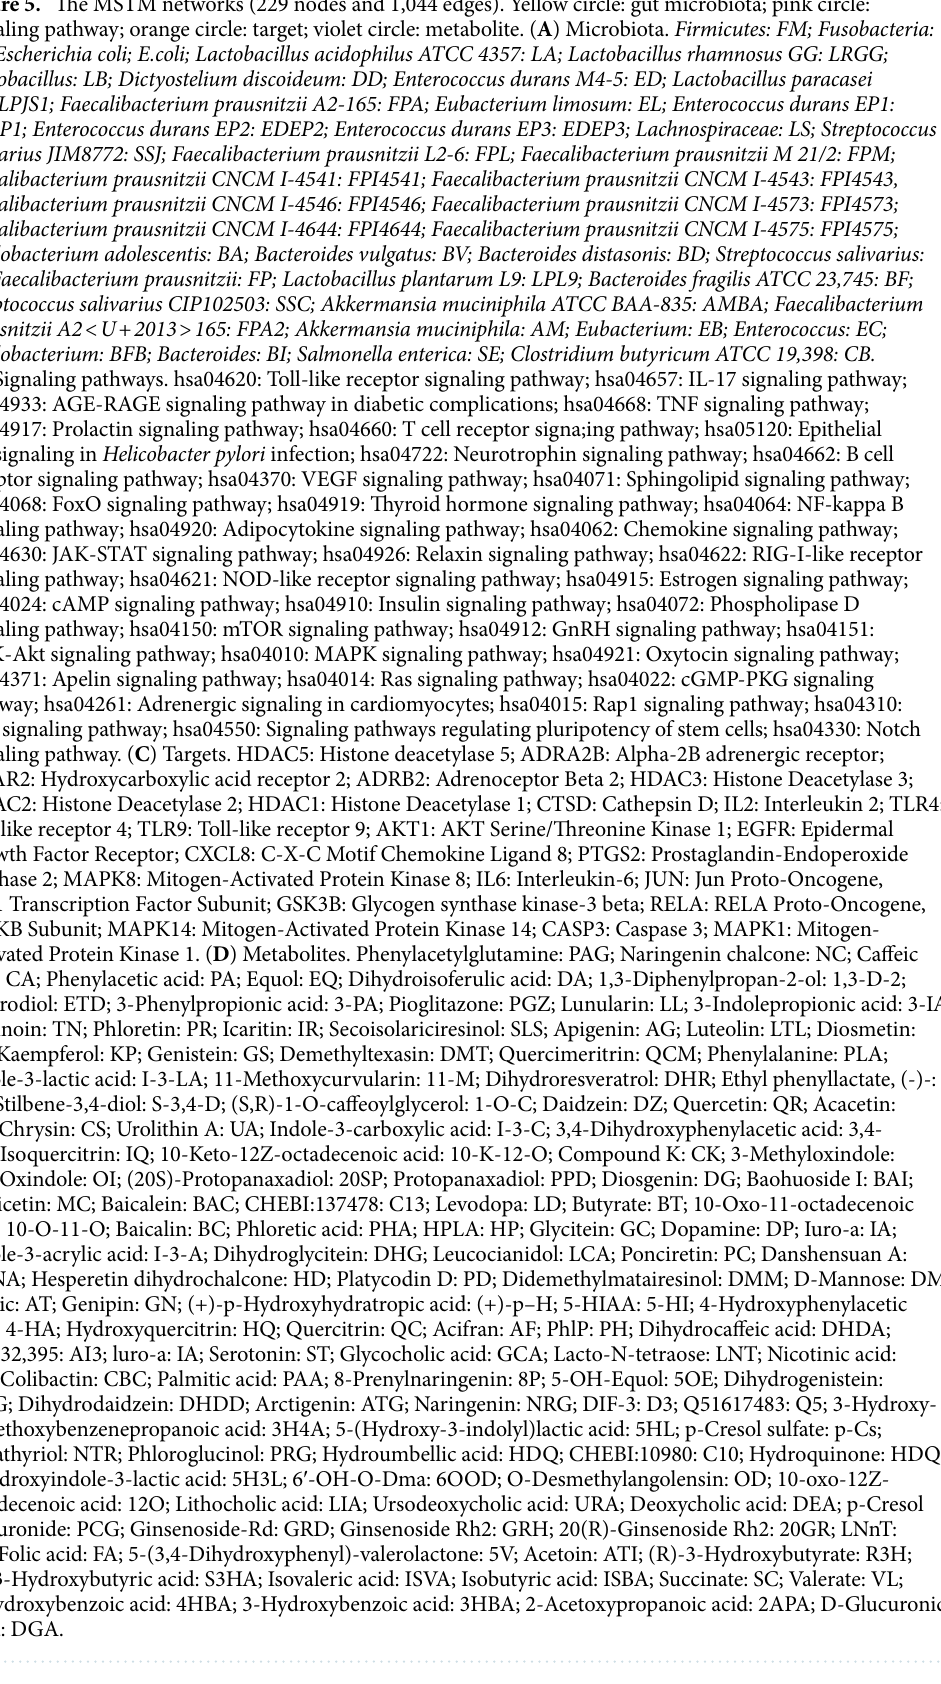
Figure 5. The MSTM networks (229 nodes and 1,044 edges). Yellow circle: gut microbiota; pink circle: signaling pathway; orange circle: target; violet circle: metabolite. ( A ) Microbiota. Firmicutes: FM; Fusobacteria: FB; Escherichia coli; E.coli; Lactobacillus acidophilus ATCC 4357: LA; Lactobacillus rhamnosus GG: LRGG; Lactobacillus: LB; Dictyostelium discoideum: DD; Enterococcus durans M4-5: ED; Lactobacillus